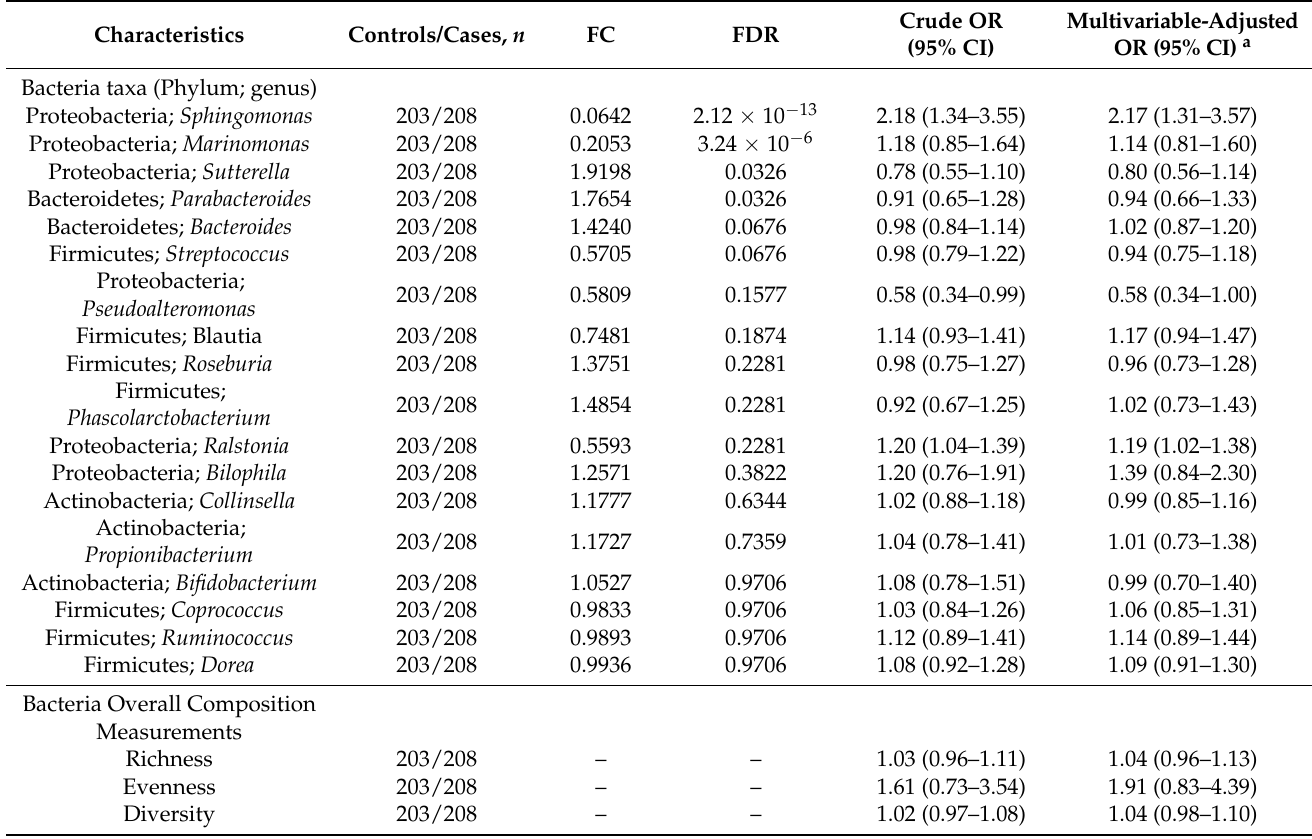
Table 3. Associations between gut microbiota and colorectal adenomas, Diet and Health Study